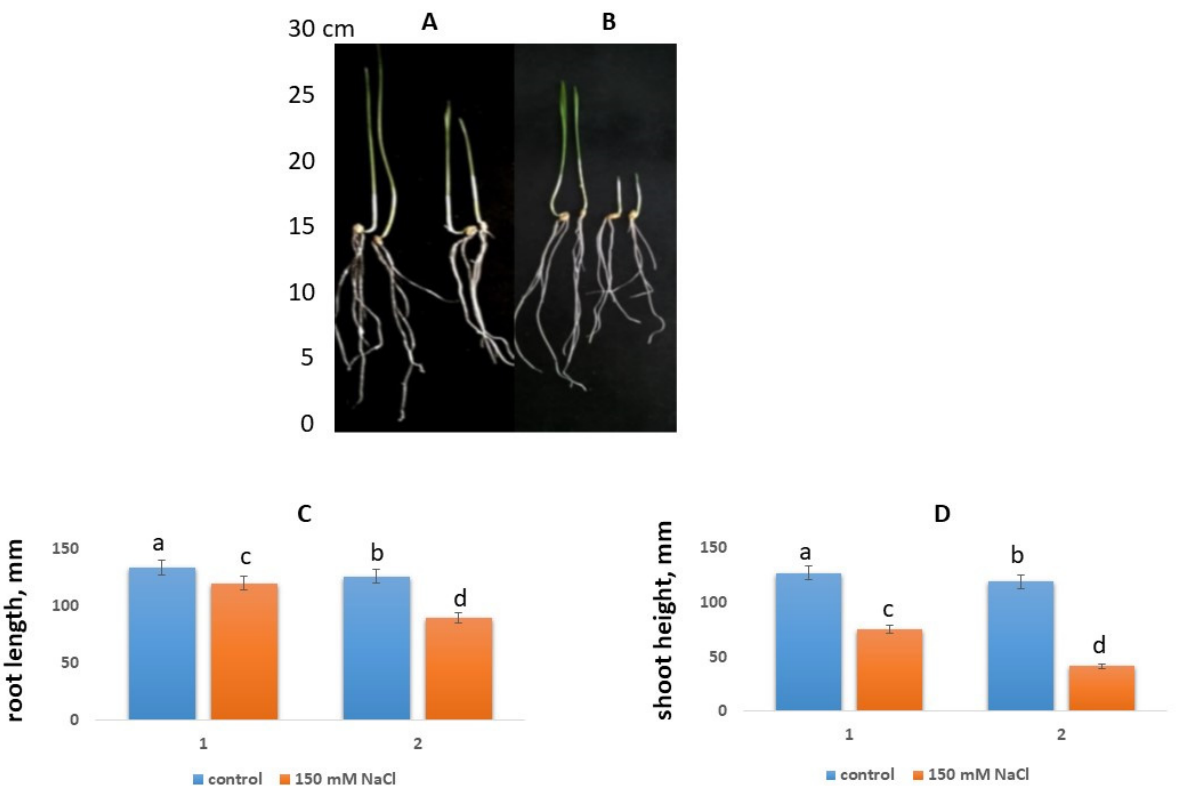
Figure 1. 10-day seedlings of wheat after germination under normal conditions (left) and chloride salinization (right) in roll culture. ( A )—Variety Orenburgskaya 22; ( B )—variety Zolotaya; ( C , D )—biometric parameters; ( C )—Root length: ( D )—Shoot length: 1—variety Orenburgskaya 22; 2—variety Zolotaya. Blue—control, Orange—150 mM NaCl. The mean values ( n = 30) and their standard deviations, p < 0.05. Different letters indicate significant differences at p < 0.05.